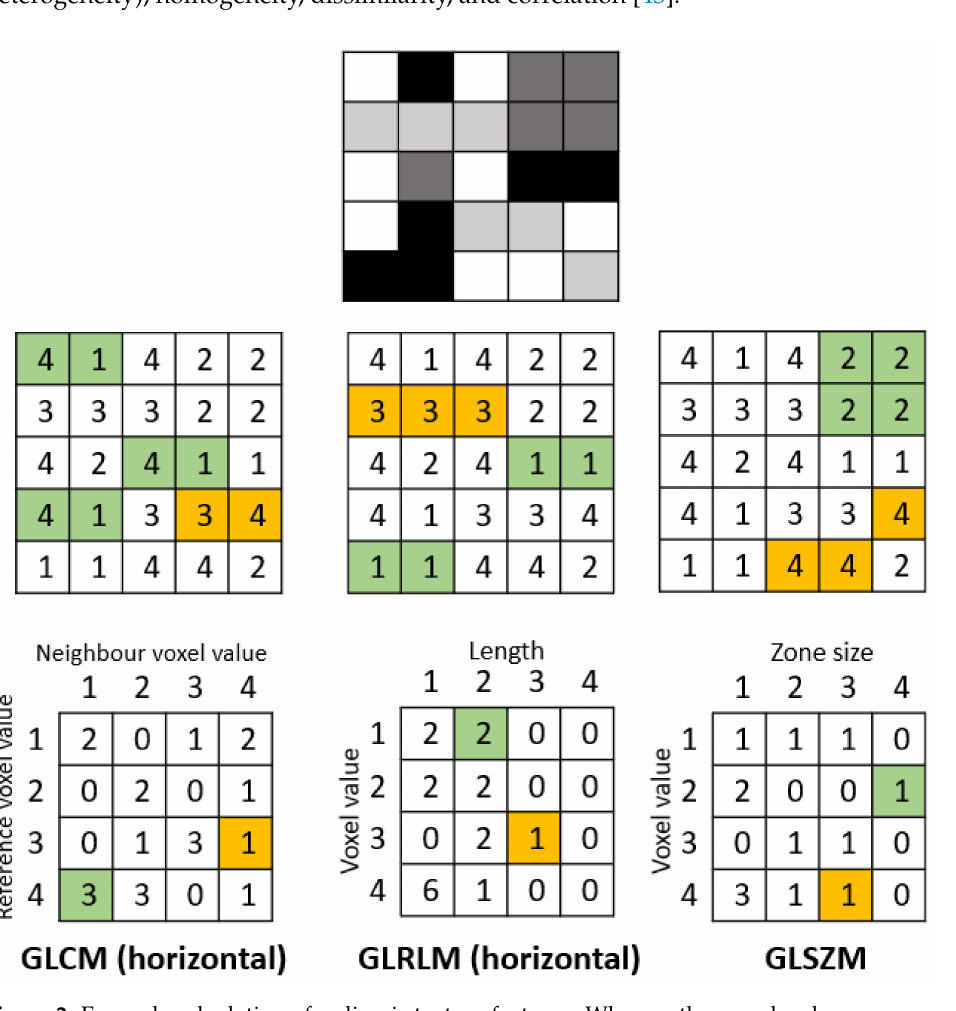
Figure 2. Example calculation of radiomic texture features. Whereas the gray-level co-occurrence matrix (GLCM) relies on pixel pairs, the gray-level run-length matrix (GLRLM) relies on runs, and the gray-level size zone matrix (GLSZM) relies on areas of neighboring pixels with the same gray-level. Gray-level run-length matrix (GLRLM) quantifies consecutive voxels with the same intensity along fixed directions (Figure 2) [44]. It is represented as a two-dimensional matrix in which each element describes the number of times a gray level appears consecutively in the direction specified. Gray-level size zone matrix (GLSZM) is a matrix in which the elements at row r and column s store the number of zones (the connected voxels with the same gray level) with gray level r and size s (Figure